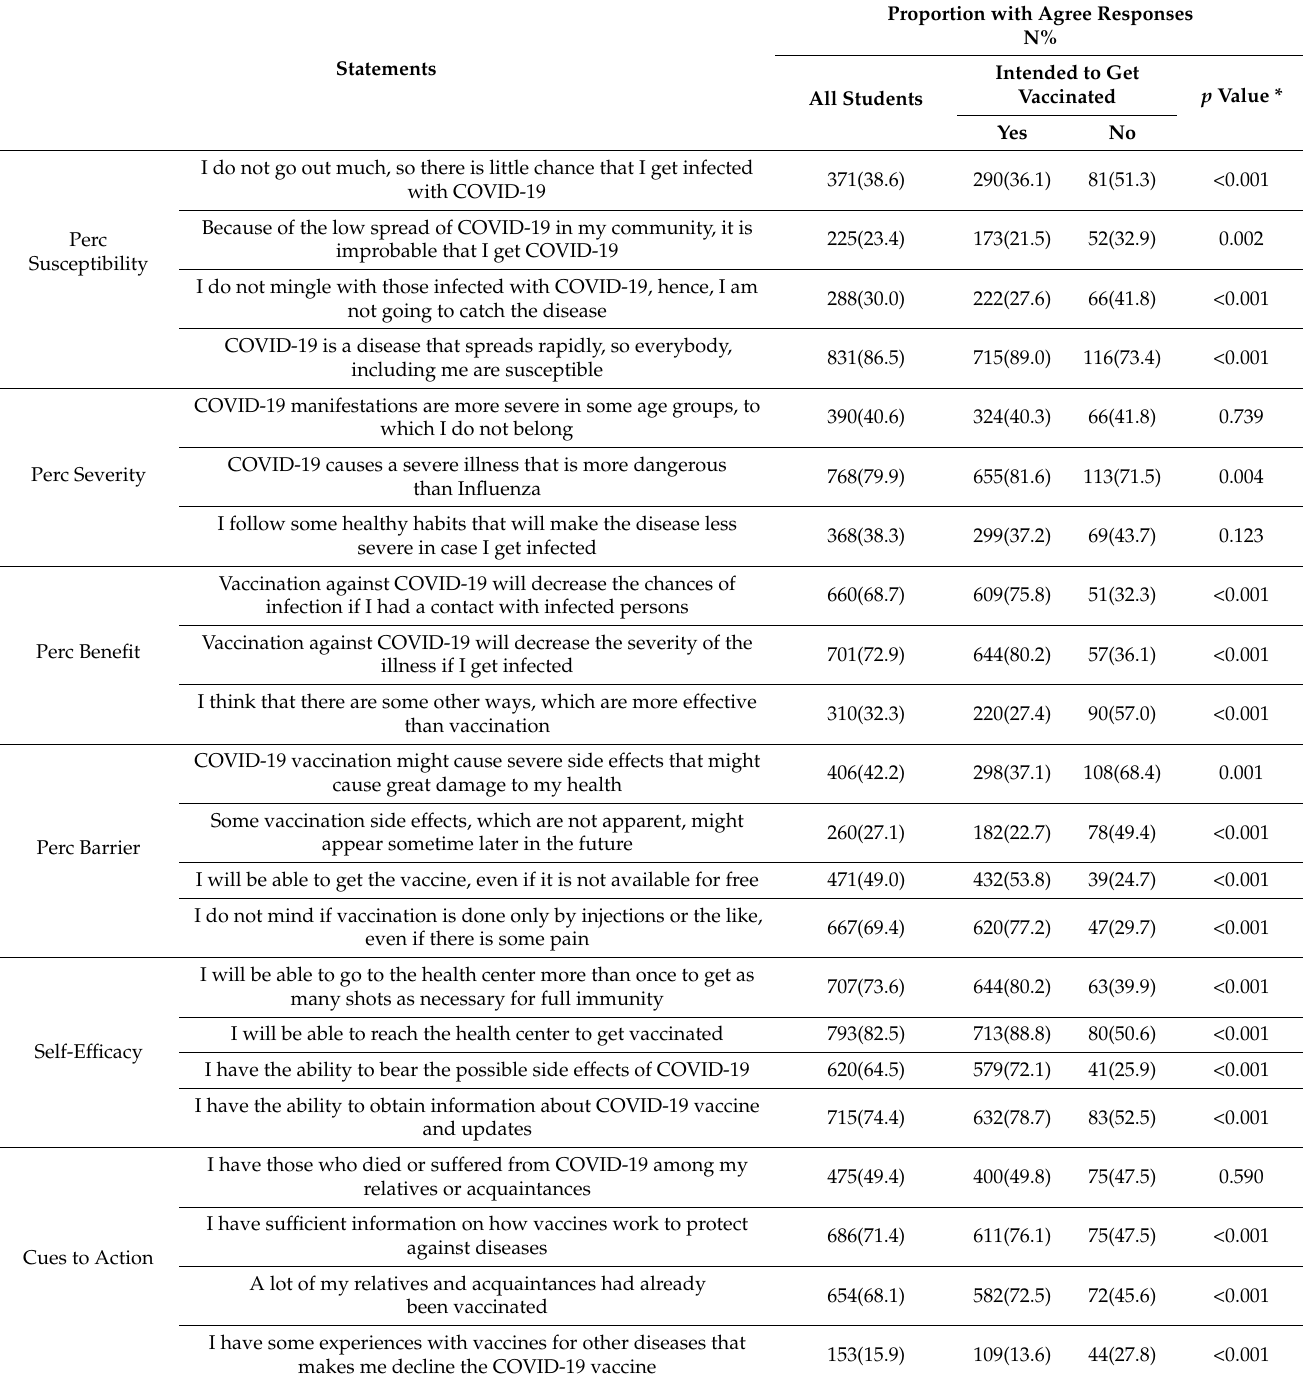
Table 2. Study participant responses on items of the health belief model according to the intention to be